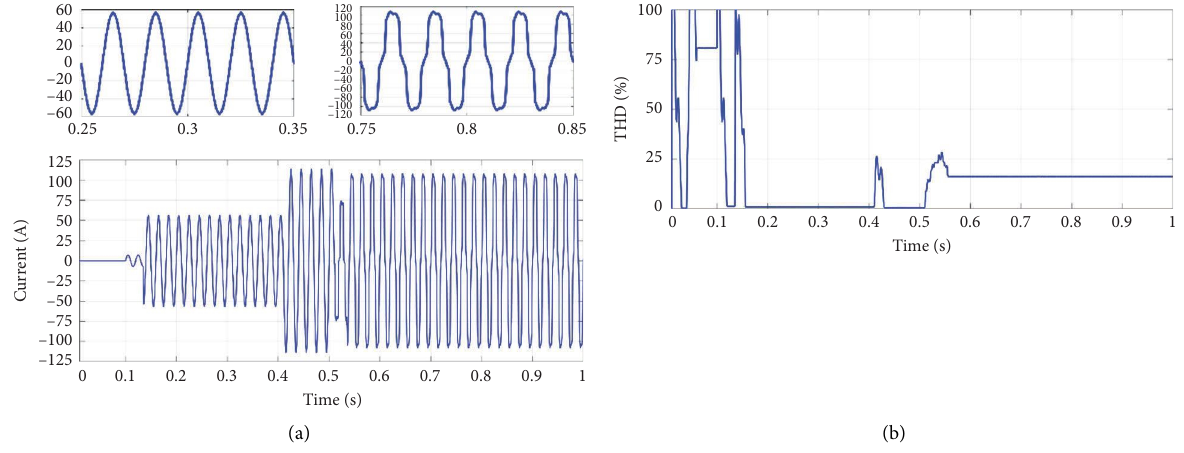
Figure 24: Filter current injected by wind generator (a) and its THD